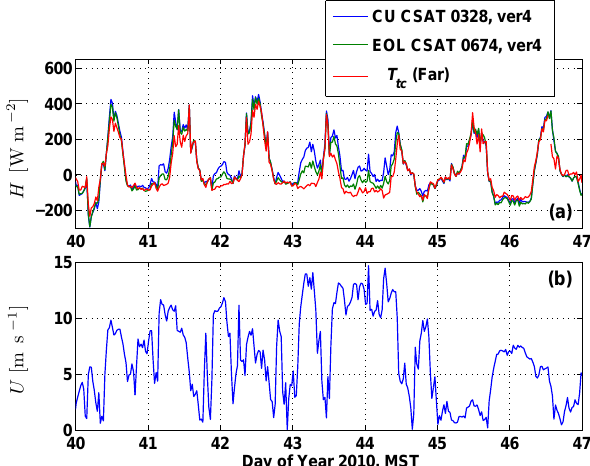
Fig. 1. Time series of 21.5m (a) sensible heat flux H and (b) hor- izontal wind speed U . H is calculated using temperature from ei- ther a sonic anemometer or the far thermocouple T tc as specified in the legend (see Table 1 for details). The thermocouple uses the CU CSAT vertical wind to determine H